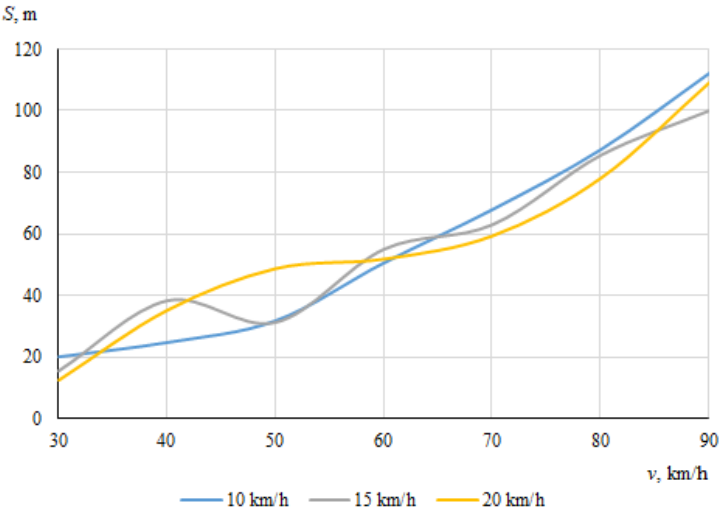
Figure 10. Throwing distances of the bicycle (impact angle 30 ◦ ).